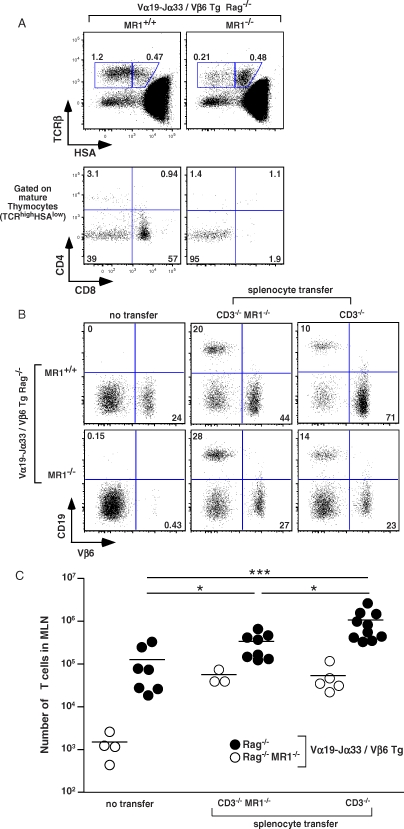
B Cells Are Not Required for Intra-Thymic MAIT Cell Development although B Cells Induce Peripheral Expansion of MAIT Cells(A) Representative HSA and TCRβ staining (upper panel) and CD8 and CD4 staining gated on mature thymocytes (lower panel) in iVα19-Jα33/Vβ6 transgenic mice in a MR1+/+ or MR1−/− RAG−/− background (left and right panel, respectively). Percentages of mature and intermediate T cells are boxed (upper panel). Representative of four mice in each group.(B) Representative Vβ6 and CD19 staining gated on MLN lymphocytes from iVα19/Vβ6 double transgenic RAG−/− mice on a MR1+/+ (upper panels) or MR1−/−  (lower panels) background without (left panels) or 14 d after MR1− or MR1+ CD3ɛ−/− splenocyte transfer. Representative of three to ten mice per group.(C) Absolute numbers of T lymphocytes in the MLN of the different groups analyzed: MR1+/+ (filled circles) and MR1−/− (open circles) iVα19/Vβ6 double Tg RAG−/− mice, without or after MR1− or MR1+ CD3ɛ−/− splenocyte transfer. *, p < 0.021; ***, p = 0.0007.